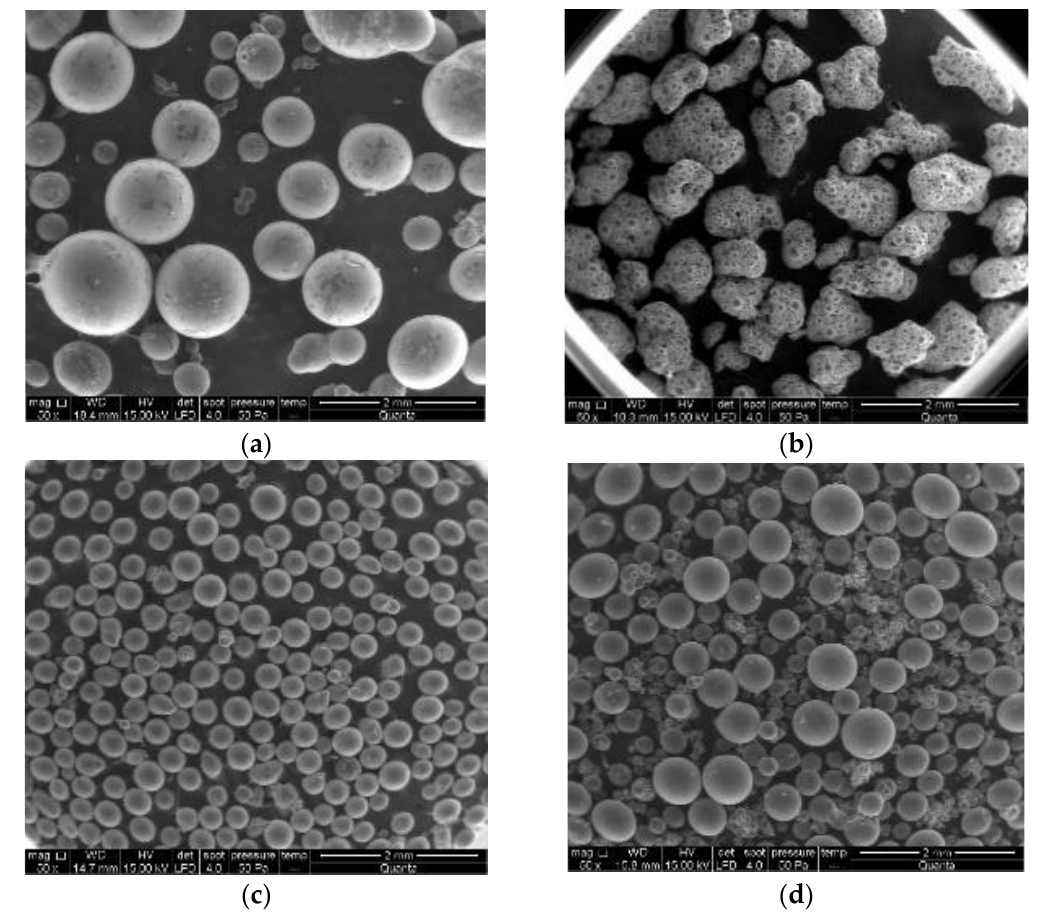
Figure 2. SEM micrographs of the different synthesized particles: St-DVB ( a ), St-DVB-PEGMA ( b ), St-DVB-GMA ( c ), and St-DVB-GMA-PEGMA ( d ).